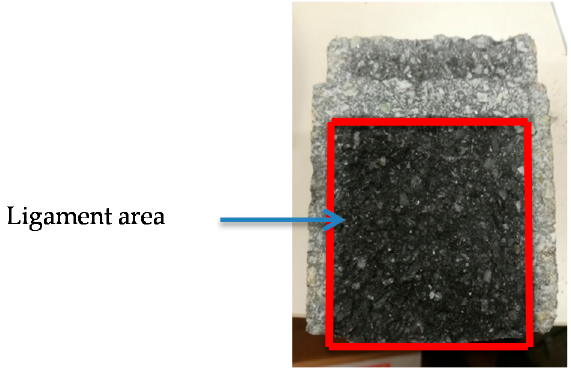
Figure 7. Sample after a wedge-splitting test at 1470 °C.